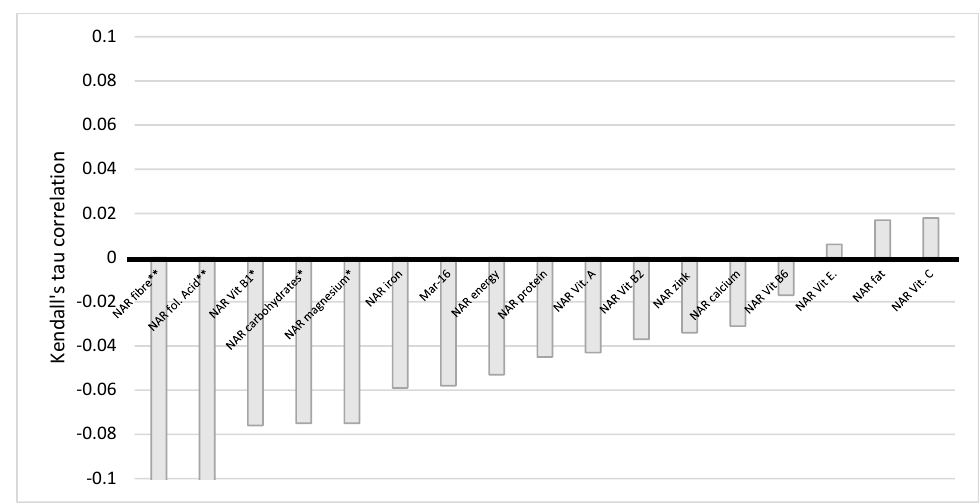
Figure 5. Correlation of NAR for nutrients with income . NAR—nutrient adequacy ratio; Mar-16— mean nutrient adequacy for 16 nutrients * p -value < 0.05; ** adjusted p -value < 0.05.